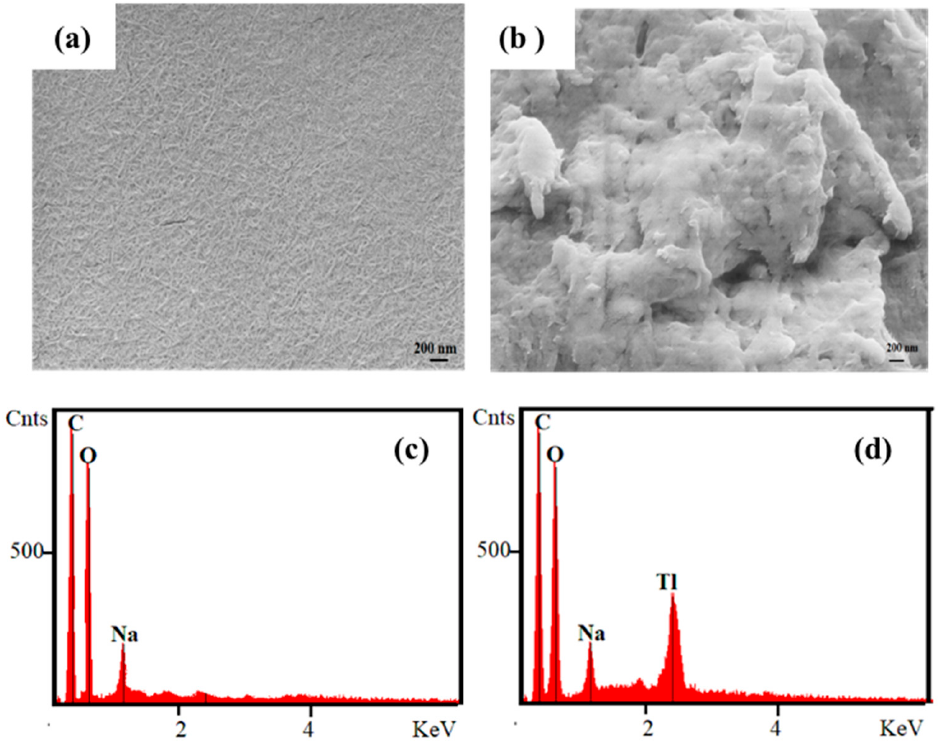
Figure 8. SEM of ( a ) NOCNF (0.32 wt%) and ( b ) NOCNF-Tl floc (0.32 wt% NOCNF with 300 ppm Tl(I)). Corresponding EDS spectra of ( c ) NOCNF (0.32 wt%) and ( d ) NOCNF-Tl floc (0.32 wt% NOCNF with 300 ppm Tl(I)).